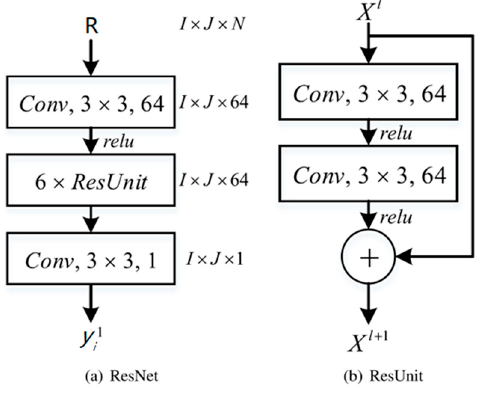
Figure 3. The structure of the prediction model.